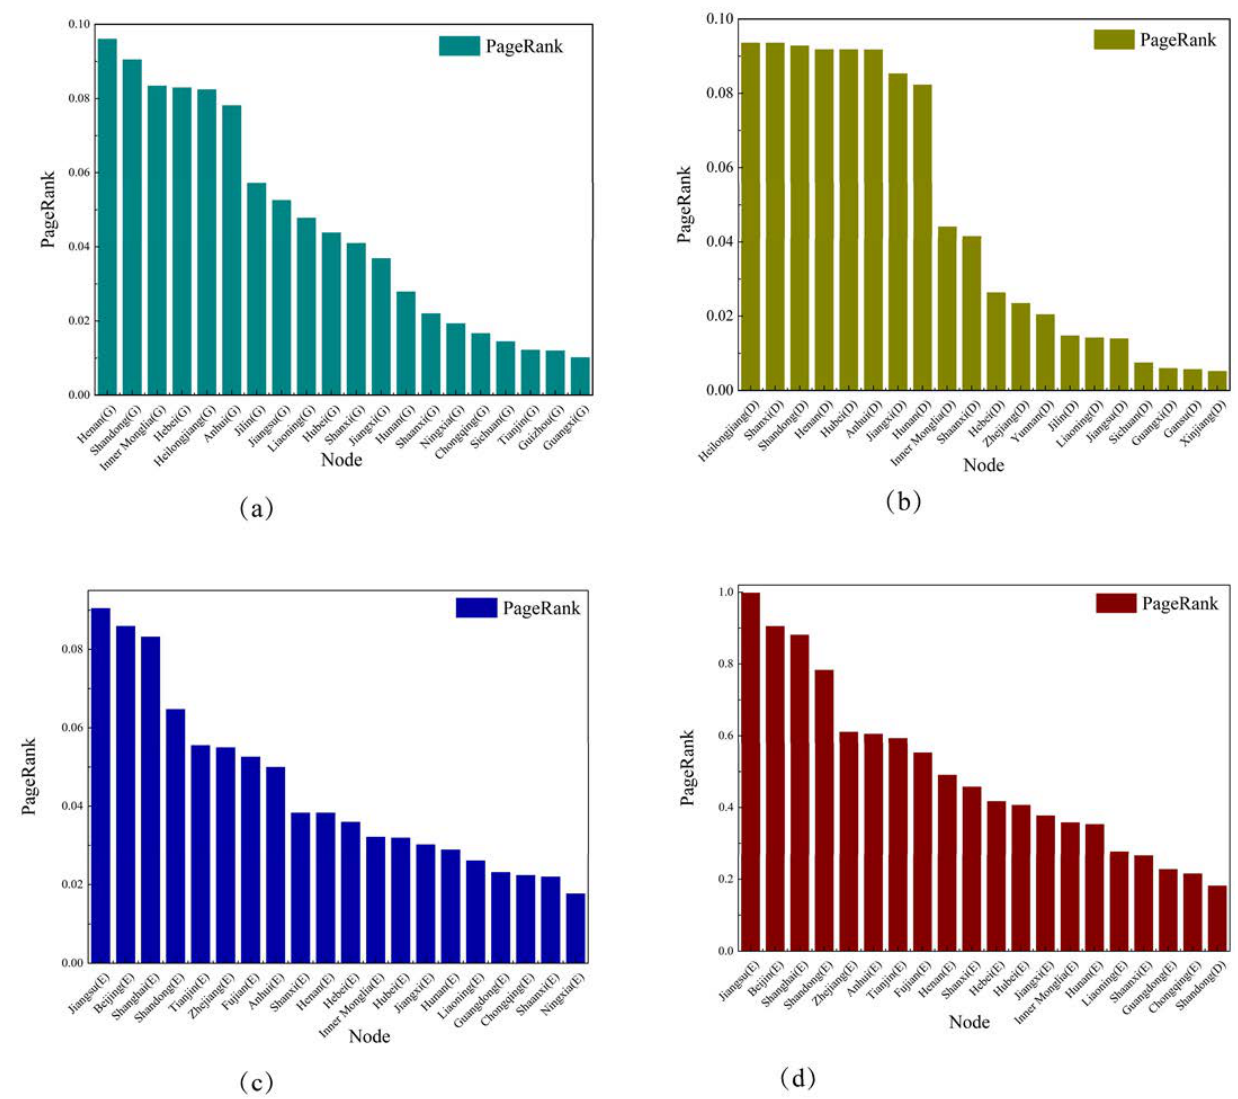
Figure 7. Top 20 nodes in terms of PageRank centrality in the networks. ( a ) Grain layer; ( b ) Disaster layer; ( c ) Economy layer; ( d ) The grain-disaster-economy multilayer. (The nodes with the top 20 by PageRank centrality values are selected in the corresponding network